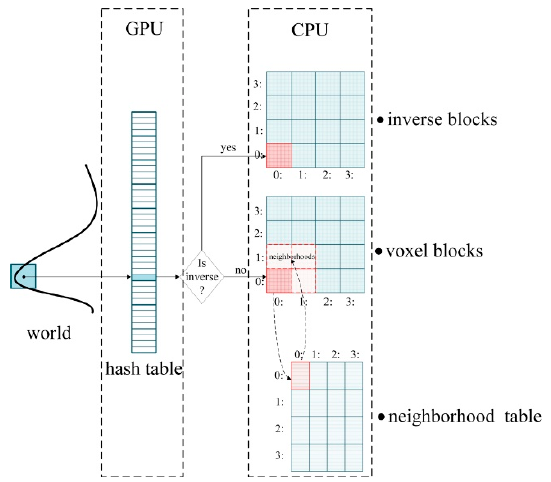
Figure 12. The whole data structure; first, the world coordinates of voxel center are mapped to the hash table to get the address of the voxel block on the central processing unit (CPU), and a thin-surface attribution judgment is then made to store the new TSDFs in either the non-inverse block or the inverse block; the subscripts of the neighborhood lookup table correspond to the individual blocks and each element of the lookup table stores the corresponding neighborhoods of the blocks; only the hash table is stored on the graphics processing unit (GPU), and all other data is stored on the CPU.